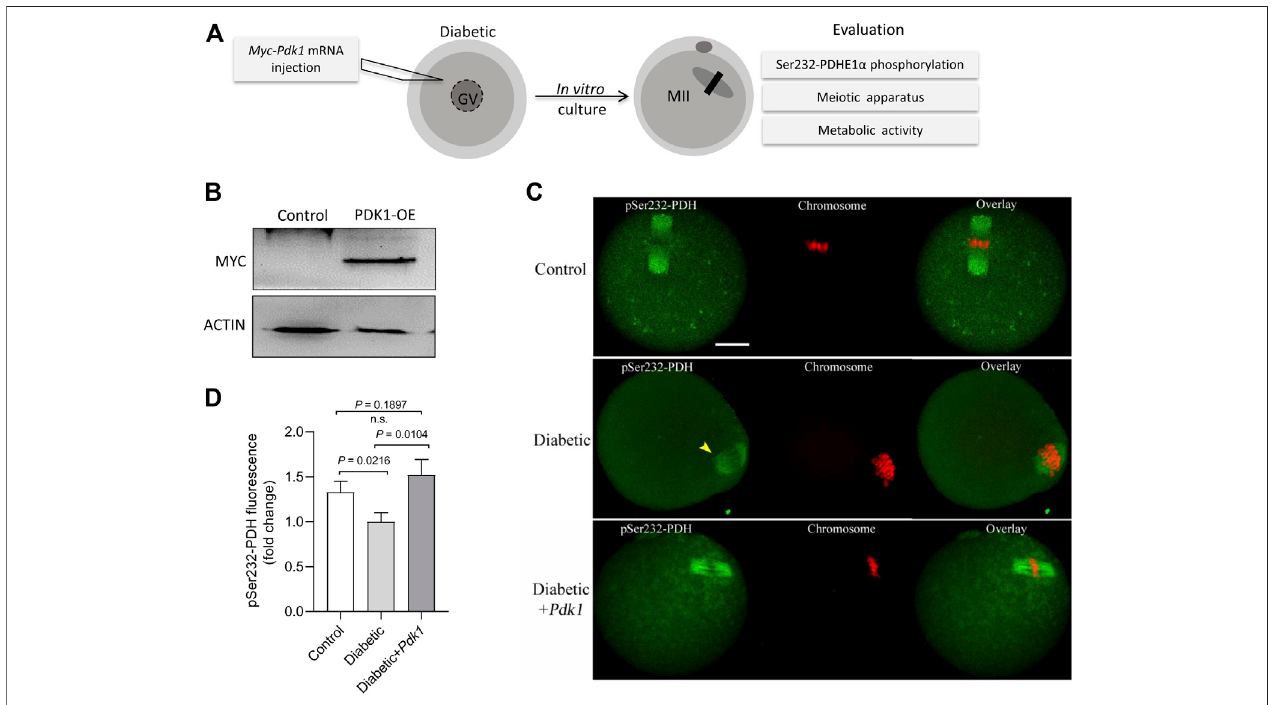
FIGURE 3 | PDK1 overexpression increases the phosphorylation level of Ser232-PDHE1 α in diabetic oocytes. (A) Diagram showing the experimental protocol to examine the effects of PDK1 overexpression on meiotic apparatus in diabetic oocytes. PBS or exogenous Myc-Pdk1 mRNA was microinjected into GV oocytes. (B) Ef fi ciency of PDK1 overexpression (PDK1-OE) after mRNA injection was con fi rmed by immunoblotting, probing with anti-MYC antibody. (C) Control, diabetic, and PDK1-overexpressing diabetic oocytes were stained with pSer232-PDHE1 α antibody (green) and with PI for chromosomes (red). (D) Quanti fi cation of pSer232- PDHE1 α fl uorescence show in (C) . Scale bar: 20 µm. Error bars indicate ± SD, a Student ’ s t test was used for statistical